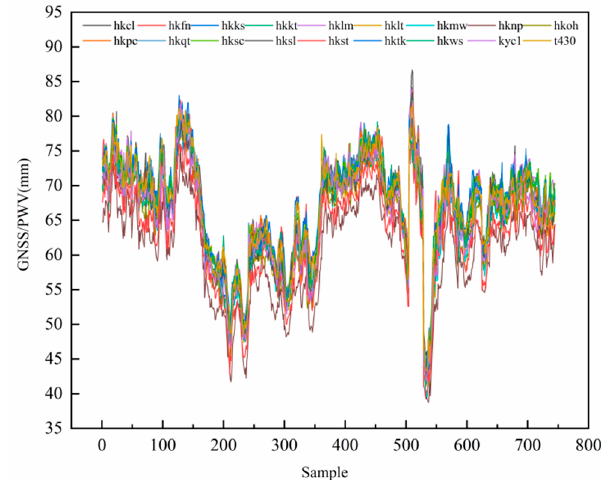
Figure 5. The overall trend for the PWV data was calculated using data from 18 CORS sites collected in July 2021, Hong Kong.